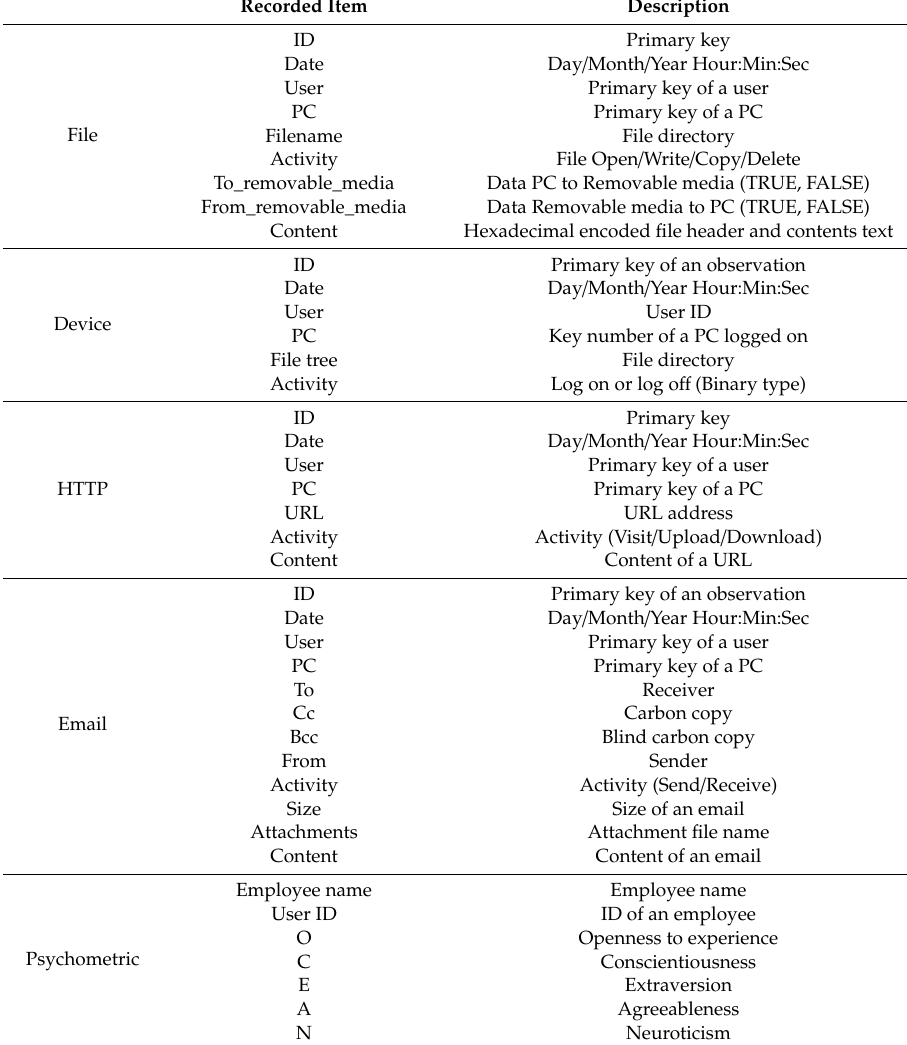
Table A1. User behavior log records of computer activities in the CERT